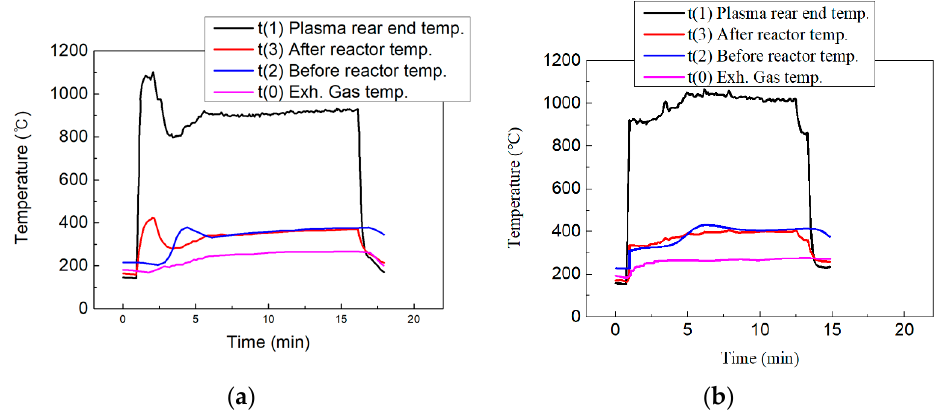
Figure 9. Temperature profiles of the plasma burner operation; ( a ) Case1, ( b ) Case2.